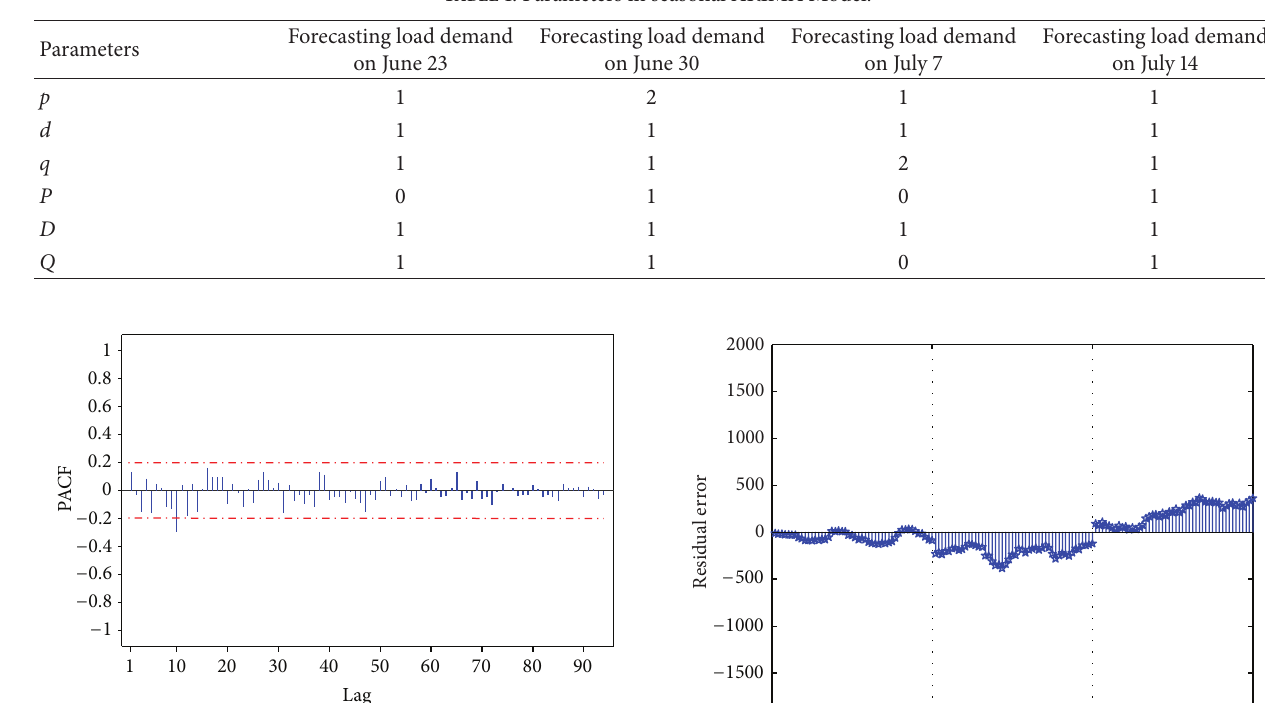
Table 1: Parameters in seasonal ARIMA Model.